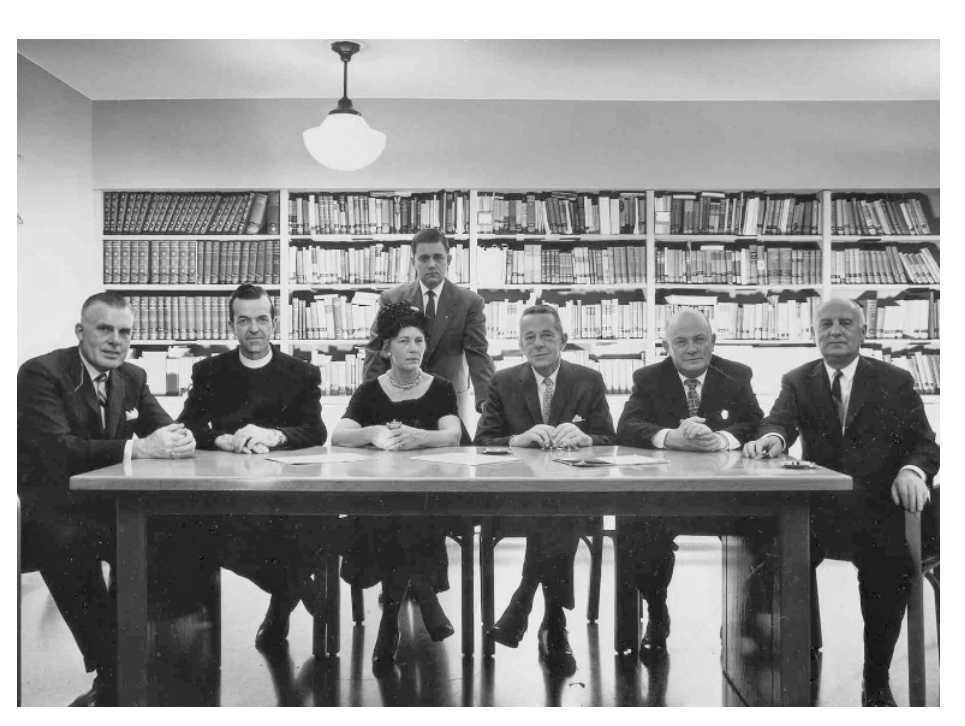
Figure 2. The “God Committee” selecting patients for dialysis. West of the Rotunda—Difficult choices. Available online: http://danschmidtforsenate.com/blog/?p=291 (accessed on 23 January 2019).